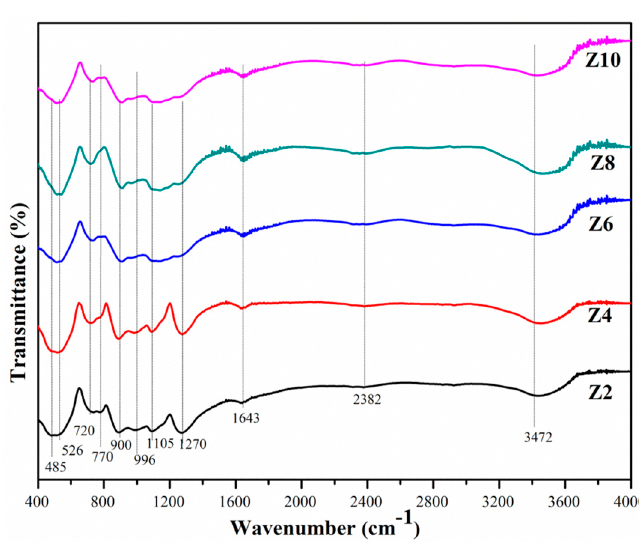
Figure 6. FTIR spectra of ZnO doped phosphate (Z2, Z4, Z6, Z8 and Z10) bioglasses.